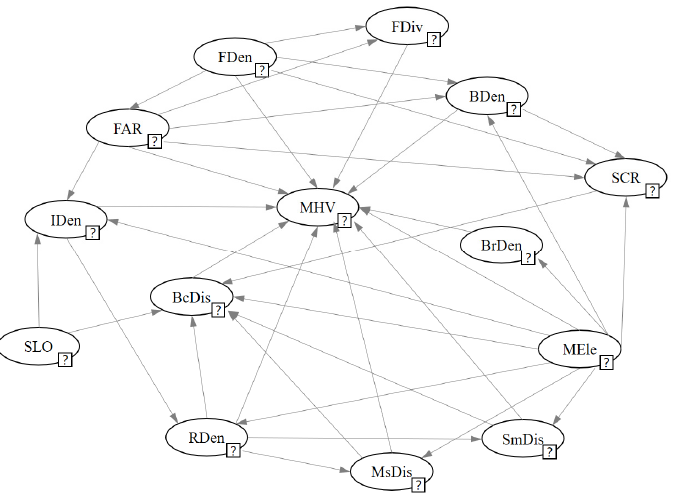
Figure 6. Final Bayesian network structure (note: the three factors of BsDen, GVR and LFac are not related to any other factors in the results, so they are not displayed in the network structure).